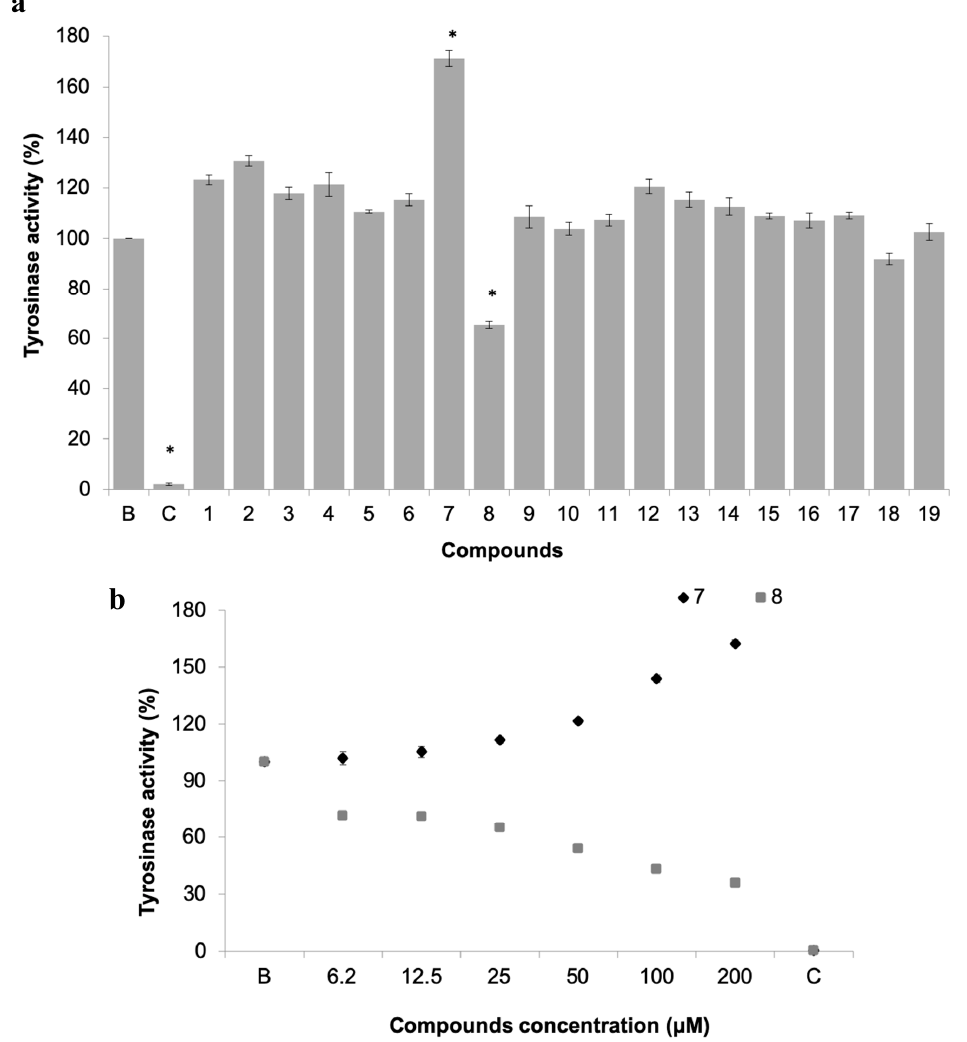
Figure 6. ( a ) Tyrosinase activity of 19 pure xanthones. * significant di ff erences ( p ≤ 0.05, Dunnett’s test) compared to the negative control (B); kojic acid was used as positive control (C). ( b ) Dose-response tyrosinase activity of selected compounds 7 and 8 .